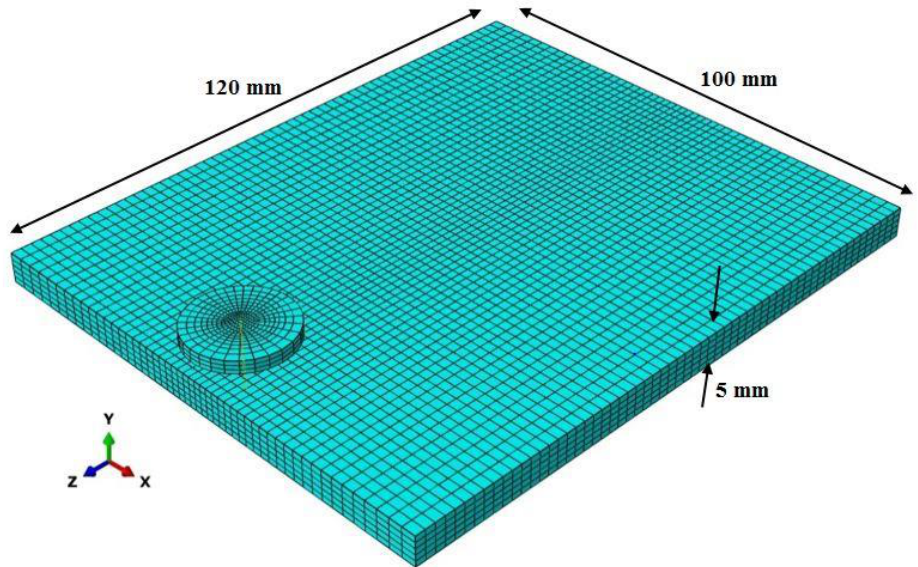
Figure 3. Final mesh used for the tool and workpiece.